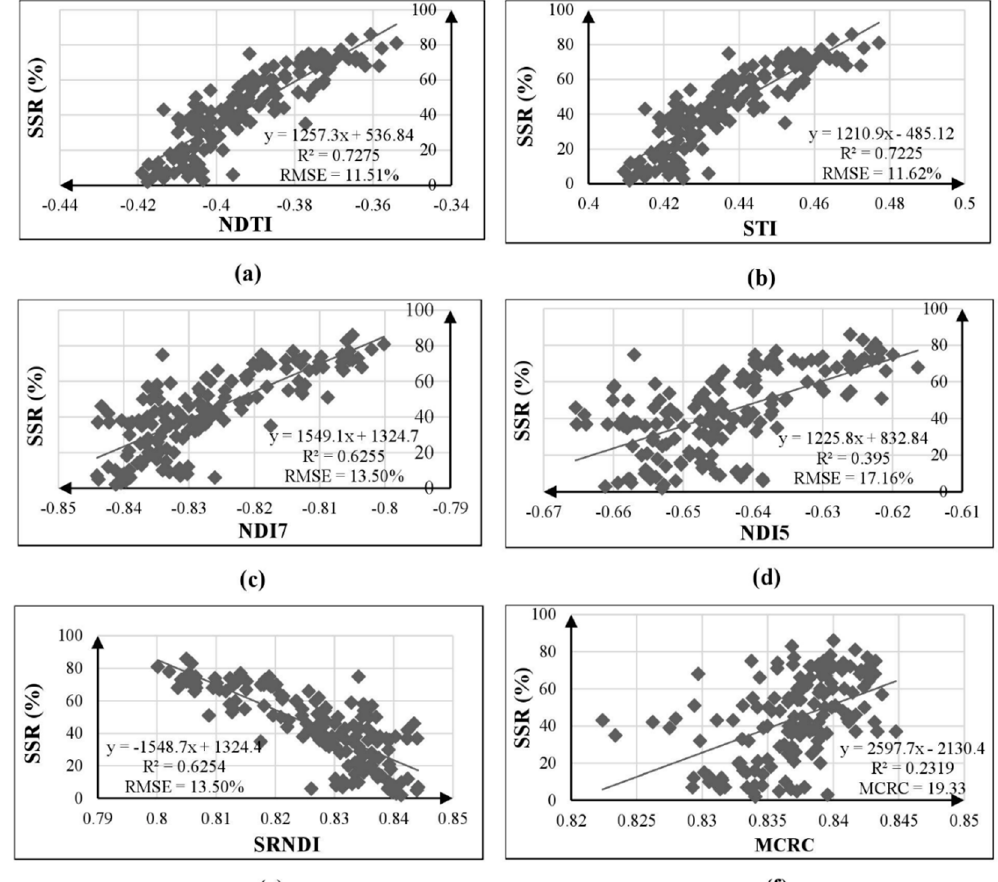
Figure 4. Correlation between Landsat-8-based tillage indices and soil surface residue (SSR). ( a ) Normalized di ff erence tillage index (NDTI), ( b ) Simple tillage index (STI), ( c ) normalized di ff erence index 7 (NDI7), ( d ) Normalized di ff erence index 5 (NDI5), ( e ) Shortwave red normalized di ff erence index (SRNDI), and ( f ) Modified crop residue cover